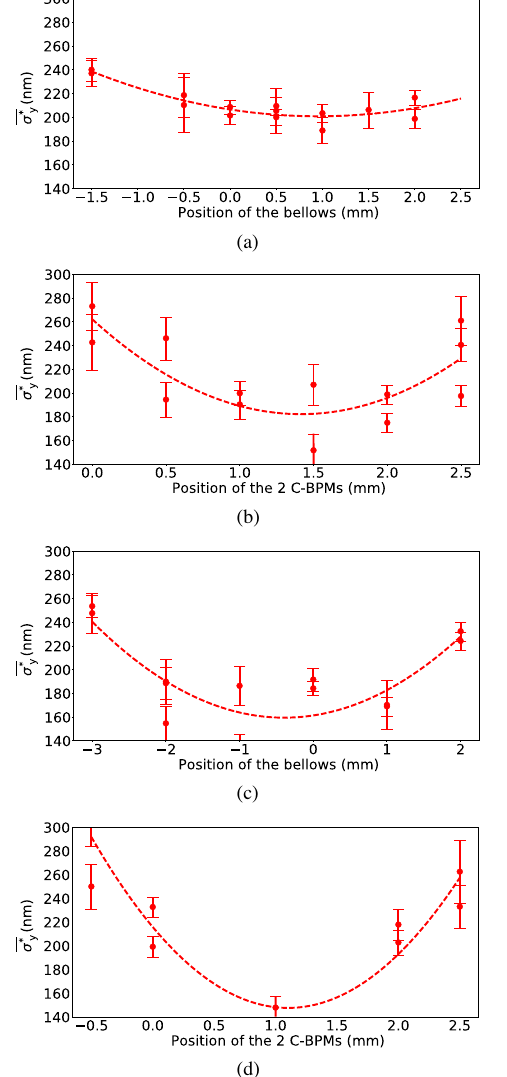
FIG. 16. σ (cid:1) y vs wakefield knob mover position for four consecutive mover iterations. (a) First iteration of the bellows mover (b) First iteration of the C-BPMs mover (c) Second iteration of the bellows mover (d) Second iteration of the C-BPMs mover.